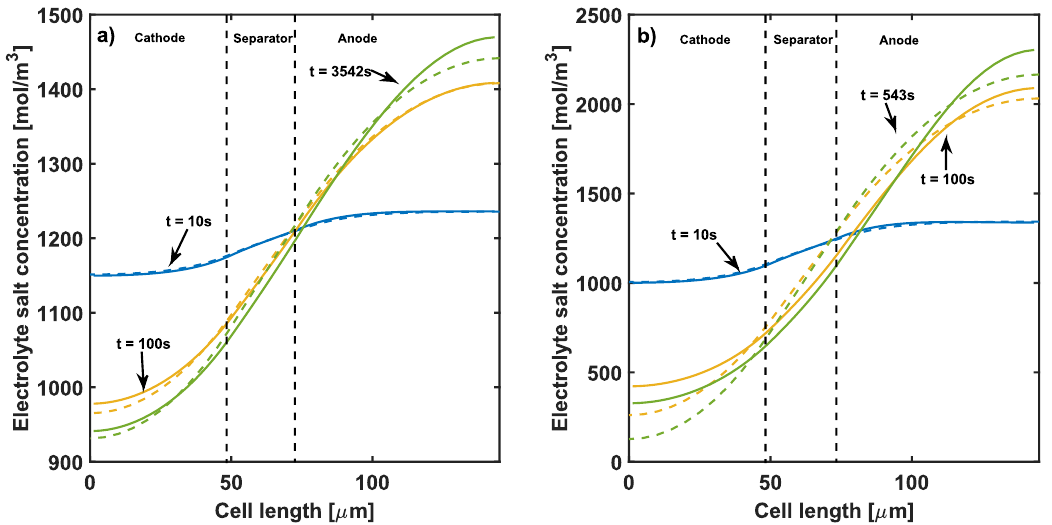
Figure 5. Comparison of electrolyte salt concentration distribution in ESM (- - dashed line) and full-order P2D model (– solid line) at ( a ) 1C and ( b ) 4C